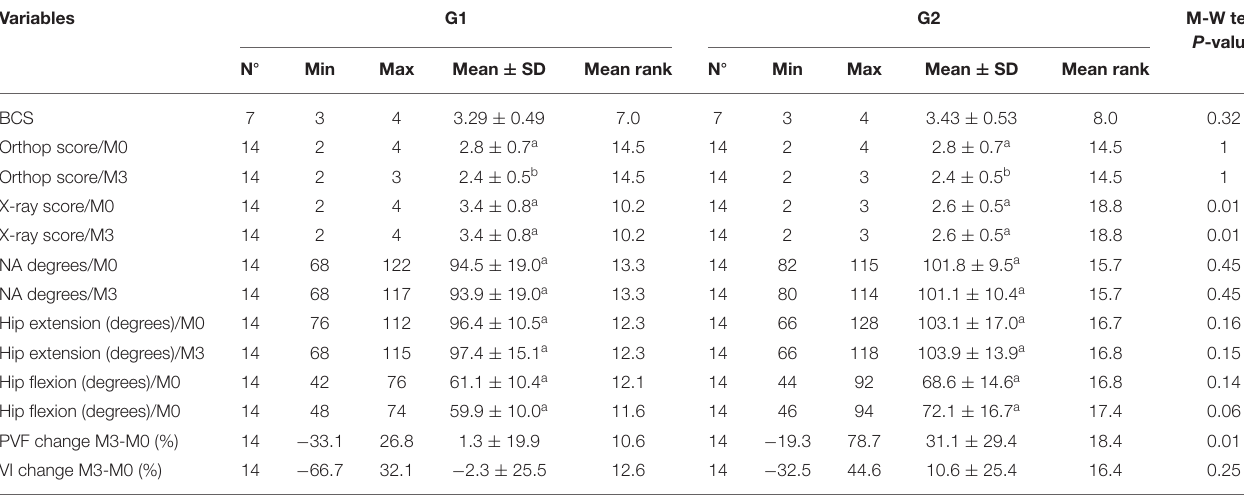
TABLE 1 | Body condition scoring (BCS), orthopedic examination score (Orthop), hip radiograph score (X-ray), Norberg Angle (NA), hip extension, hip flexion, percentage change of Peak Vertical Force (PVF) and percentage change of Vertical Impulse (VI) of the hind limbs with osteoarthritis due hip dysplasia, immediately prior to treatment (M0) and at day 90 after (M3) intraarticular injection of hyaluronic acid (Group 1, 7 dogs, 14 hind limbs), or hyaluronic acid associated with ozone gas (Group 2, 7 dogs, 14 hind limbs).